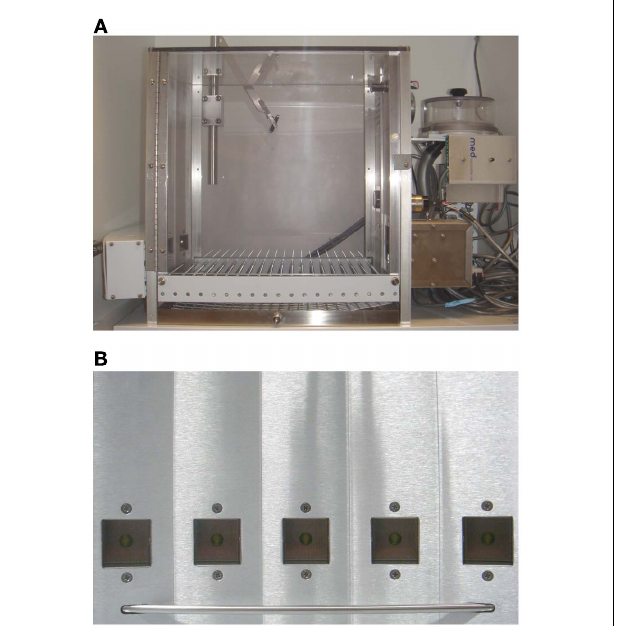
FIGURE 5 |The standard five-hole operant chamber, as used for the RGT rewardortime-out model. (A) Side view of a Med Associates five-hole box. These chambers are modular and can be configured for multiple behavioral paradigms and manipulations, hence the arm assembly for drug self-administration/microdialysis and additional levers visible. However, these components are not necessary for the RGT. (B) A close-up of the standard five-hole array showing stimulus light location and infrared